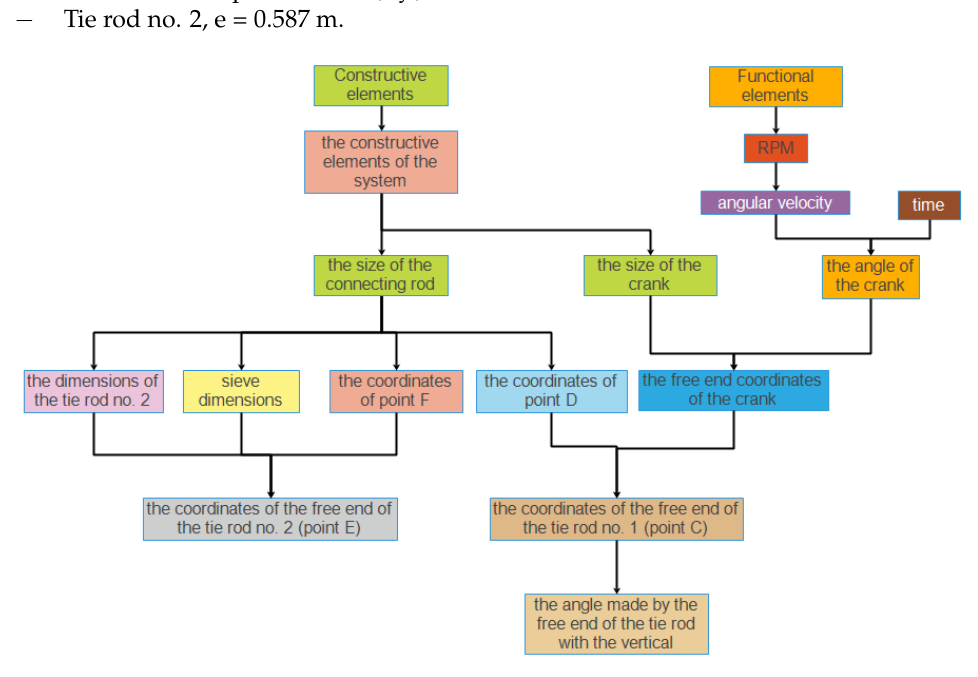
Figure 6. Description of the working methodology.